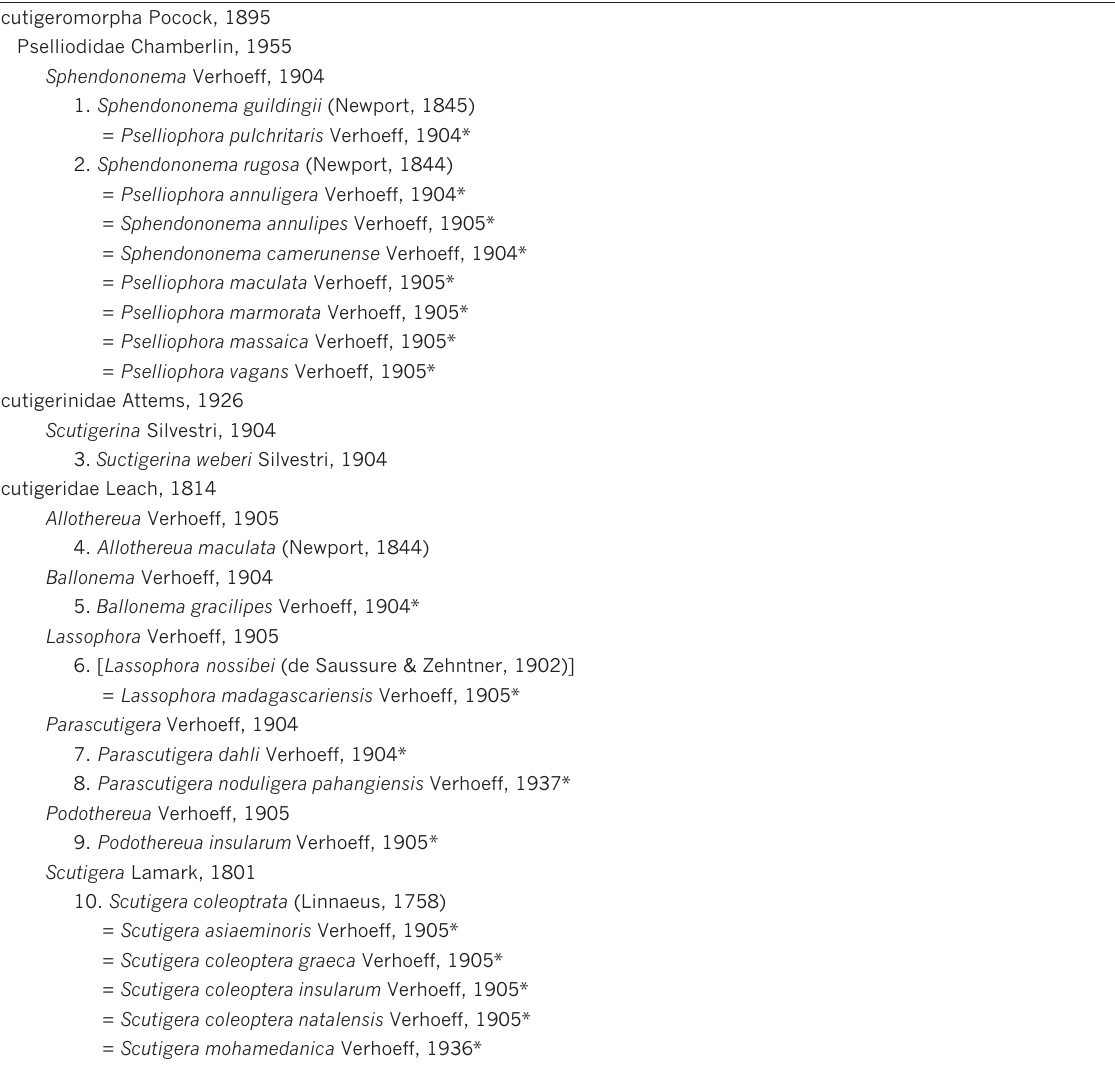
Table 1. Systematic overview of the 19 currently valid species in the ZMB scutigeromorph centipede collection. * indicates a type, either as a valid species or a junior synonym. Species in square brackets are only present by virtue of their junior synonyms and are not found in the non-type